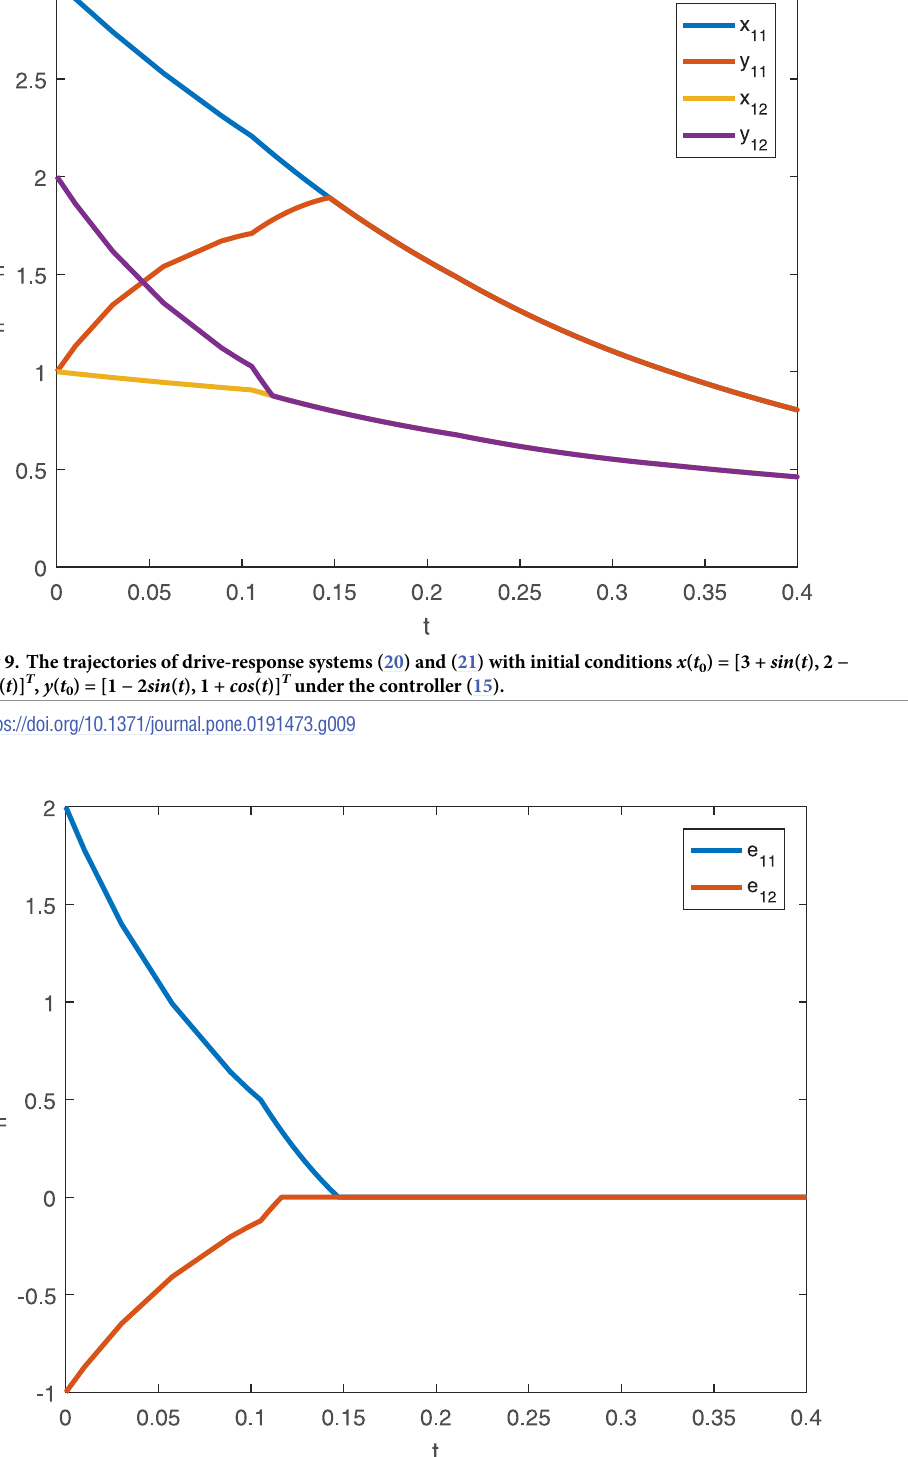
Fig 10. The error curves of drive-response systems (20) and (21) under the controller (15).